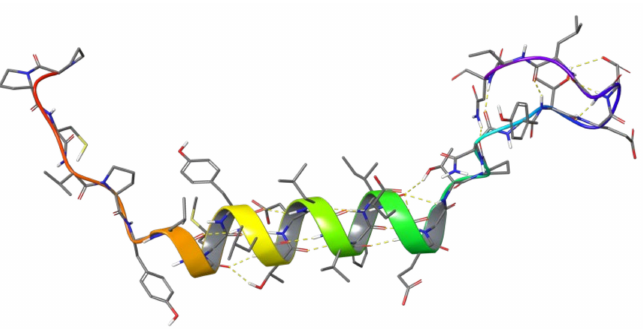
Figure 2. RB3 peptide structure including a loop from Pro1173 to Gly1180, an α -helix from Met1181 to Glu1191, and another loop from Gly1192 to